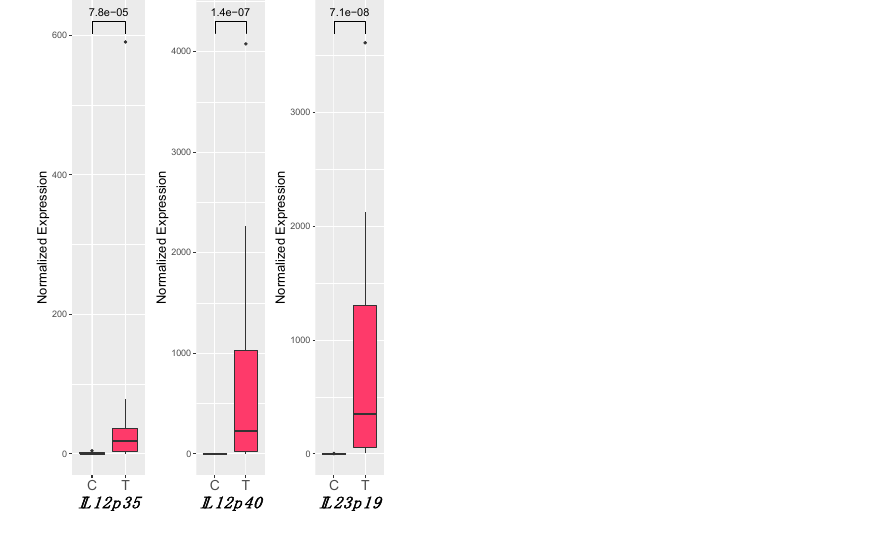
Figure 1. Gene expression levels of IL12p35 , IL12p40 , and IL23p19 . The gene expression levels were normalized to that of the reference B2M . The Mann–Whitney U -test was used for the statistical analysis. The statistically significant (P < 0.05) values for each gene are reported on the horizontal bars in the upper part of the graph (“e” stands for exponential of ten). C: control group; T: tumor group.